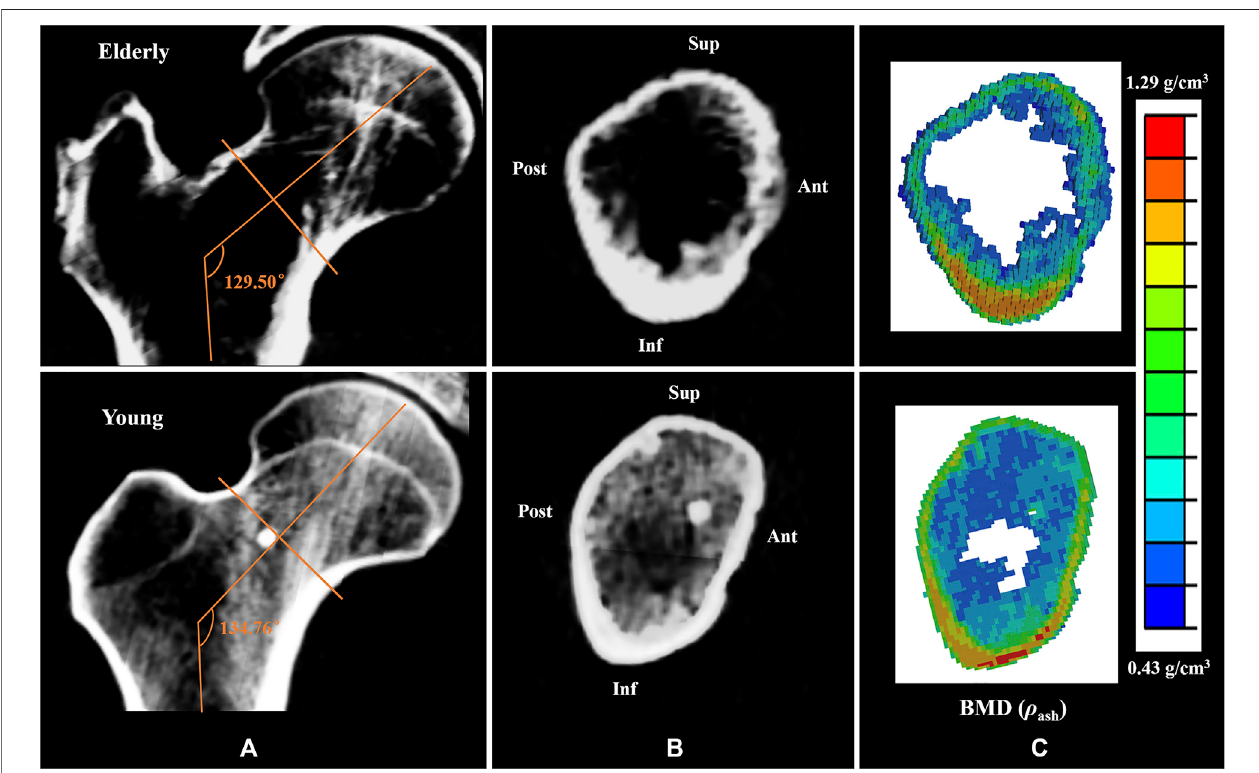
FIGURE5| ComparisonsoftheCTscanslicesandtheBMDdistributionsbetweentheelderlyandtheyoung. (A,B) theCTscanslicesoftheproximalfemurandthe mid-femoral neck, (C) the BMD distributions of the mid-femoral neck.